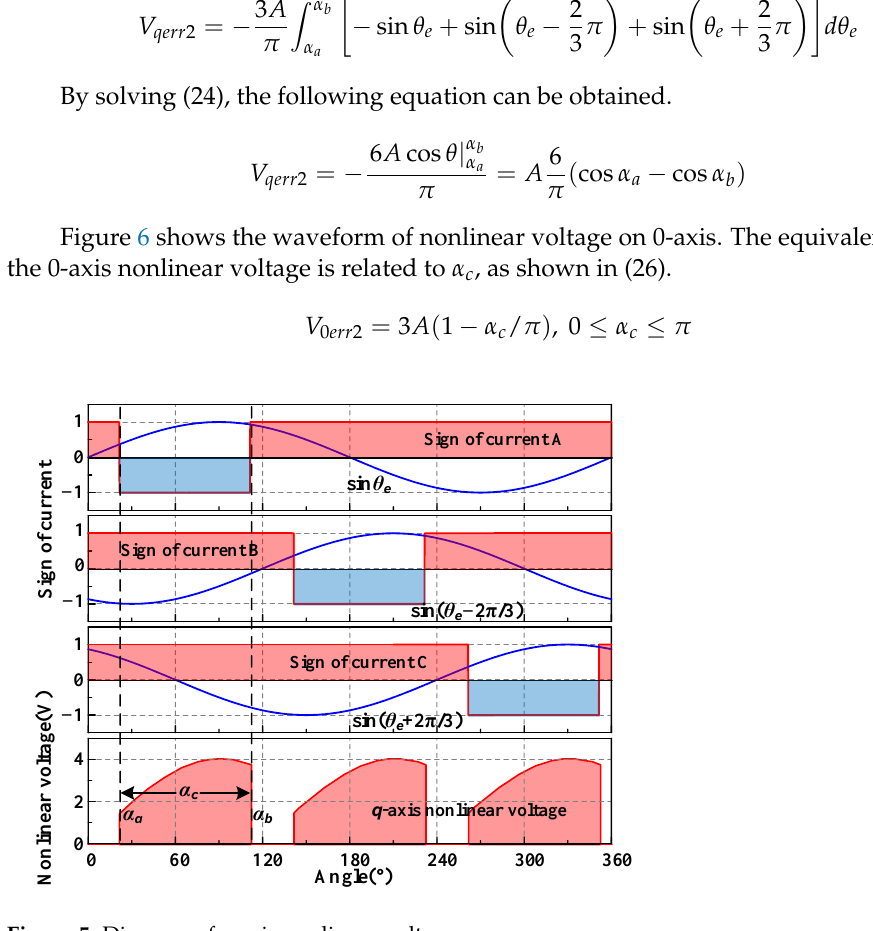
By solving (24), the following equation can be obtained.